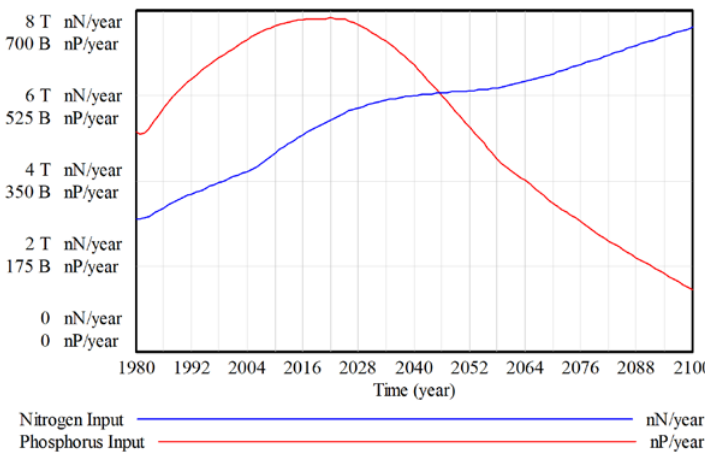
Figure 8. Total nitrogen and phosphorus input to surface water under the ANEMI3 baseline scenario. Left axis represents number of moles of nitrogen and phosphorus inputs to surface water per year.